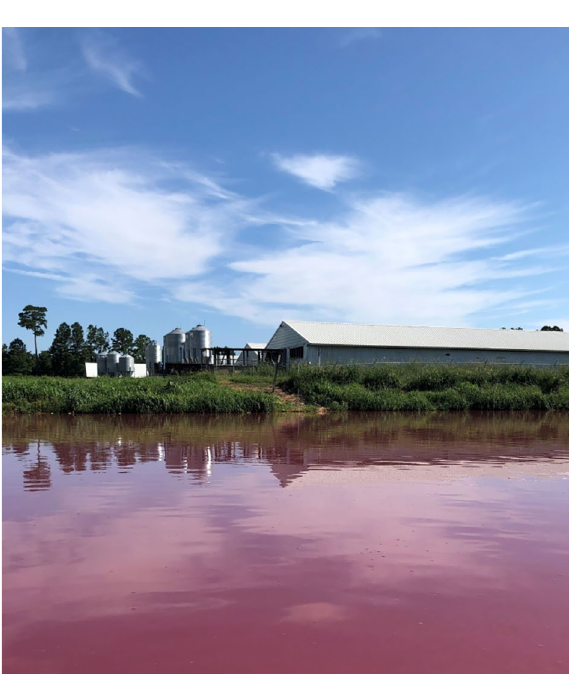
Figure 2. Swine operation and lagoon in Eastern North Carolina (July 2019). Photograph by Mahmoud